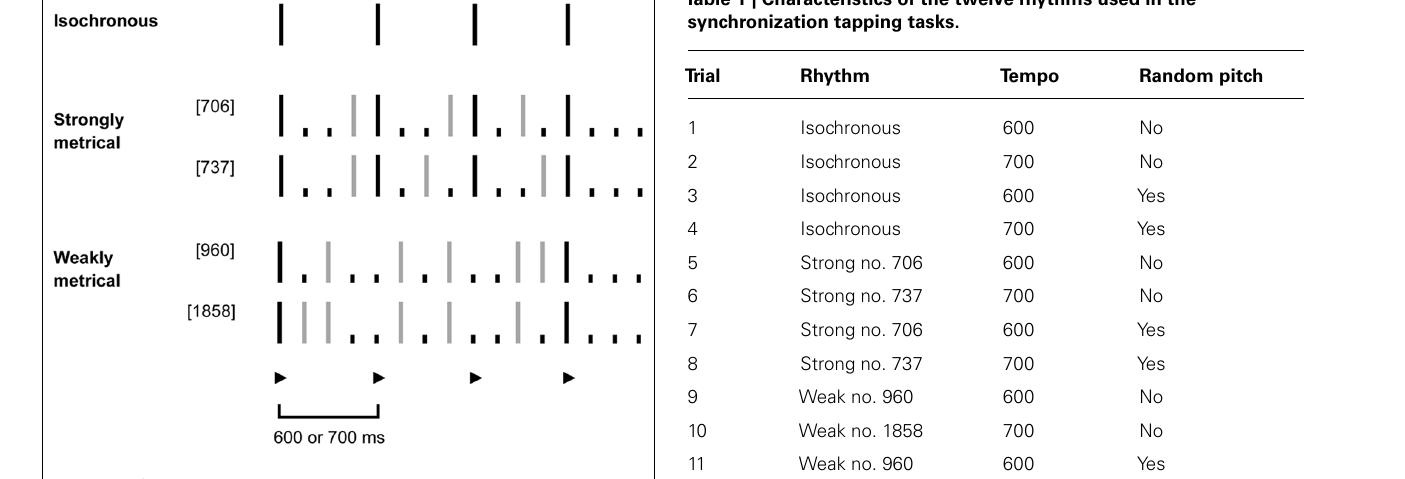
FIGURE 1 | Schematic representation of tapping stimuli: isochronous, strongly and weakly metrical tone sequences. Isochronous sequences consisted of evenly spaced tones, occurring every 600 or 700 ms (depicted in black). For the metrical sequences, the underlying meter with a beat of 4 had a corresponding period of 600 or 700 ms, respectively. The beat locations (unit 1, 5, 9, 13) are denoted by a (cid:2) . In order to induce the feeling of a metrical-beat of 4 in the listener, the strong sequences had a phenomenally (purely due to temporal spacing) accented tone on all four intended downbeat locations (depicted in black). The weak sequences in contrast had an accented tone only on the first and last downbeat (in black), but no tones on the second and third. Gray lines denote unaccented tones, dots silent units.